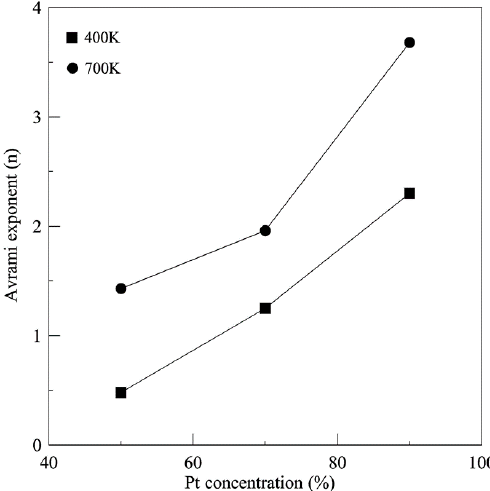
Figure 6. The change of Avrami coefficients with a Pt concentration for different annealing temperatures.